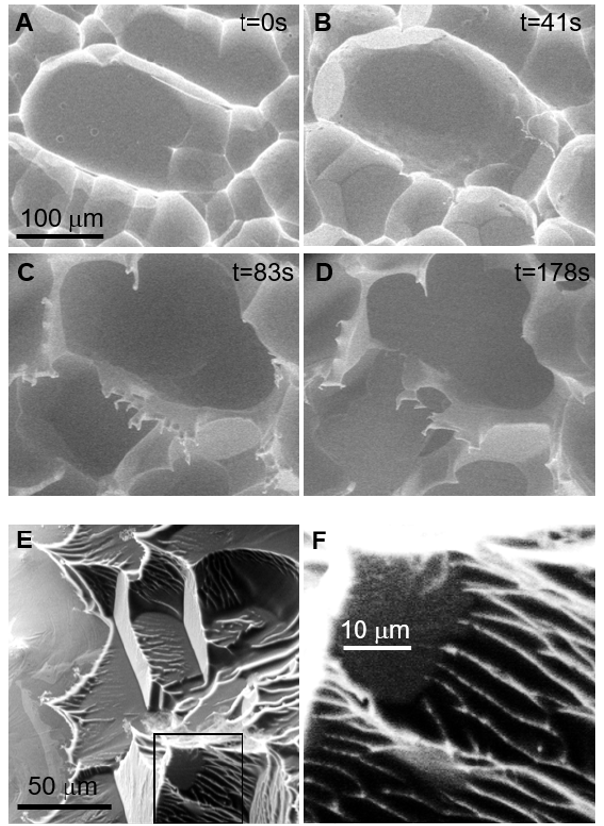
Figure 7. A thick polycrystalline ice film during sublimation. Shapes reminiscent of isolated crystals appear. In the final stage, needles/spikes develop. The smallest radii of such structures is below 10nm. ESEM imaging conditions: (a) P = 137 . 0Pa, T = − 15 . 0 ◦ C, P sat = 165 . 4Pa, h = 0 . 83; (b) P = 147 . 3Pa, T = − 13 . 5 ◦ C, P sat = 189 . 8Pa, h = 0 . 78; (c) P = 142 . 0Pa, T = − 12 . 1 ◦ C, P sat = 215 . 6Pa, h = 0 . 66; and (d) P = 129 . 0Pa, T = − 9 . 7 ◦ C, P sat = 267 . 1Pa, h = 0 . 48. The time from the onset of sub- limation is given in the figures. All images have the same scale (see c ). (e) − 20 ◦ C. The ice on the right-hand side part is much thicker than on the left and shows the typical concave scallop shape on the 10µm scale. This is also replicated on the sub-micrometre scale. The ridges (white lines) and tips appear very bright due to the high local emission current. (f) Zoom of (e)